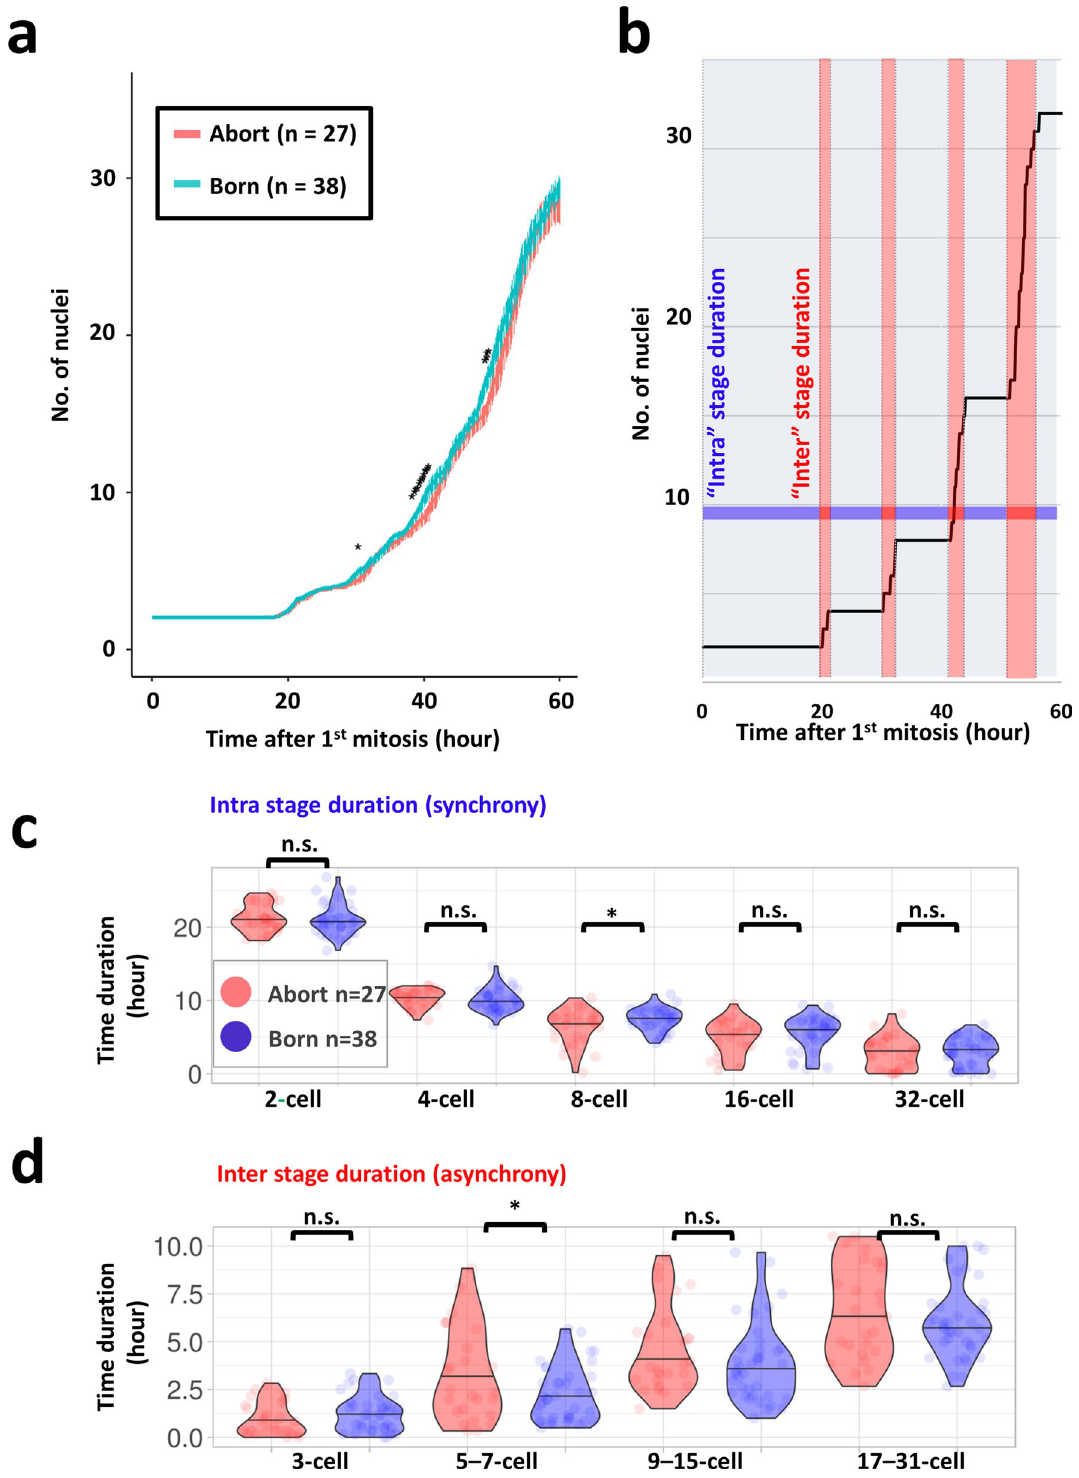
Figure 2. Comparison of cell number and time between born embryos and aborted embryos. ( a ) Comparison of averaged cell growth curves of born/abort embryos. *: significantly different. Data are represented as mean ± SD. We used 65 mouse zygotes for the retrospective study (we used 15 female and three male mice). ( b ) Schematic diagram of “Intra” stage duration and “Inter” stage duration. “Intra” stage denotes 2-, 4-, 8-, 16-, 32-cell stage duration, and Inter stage denotes 3-, 5–7-, 9–15-, 17–31-cell stage duration. When the cells were not dividing, shown in blue, the duration is the intra-stage duration. The time during which the cell was dividing, shown in red, represents the interstage duration. ( c ) Comparison of “intra” stage duration between born and abort embryos. ( d ) Comparison of “inter” stage duration between born and abort